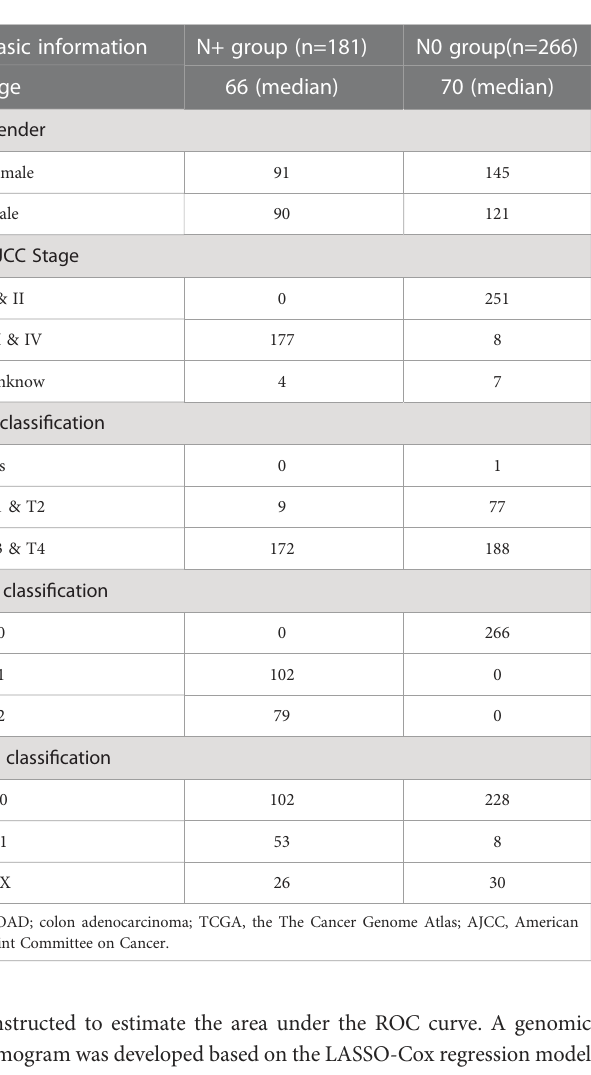
TABLE 1 Characteristics of the included COAD patients obtained from the TCGA